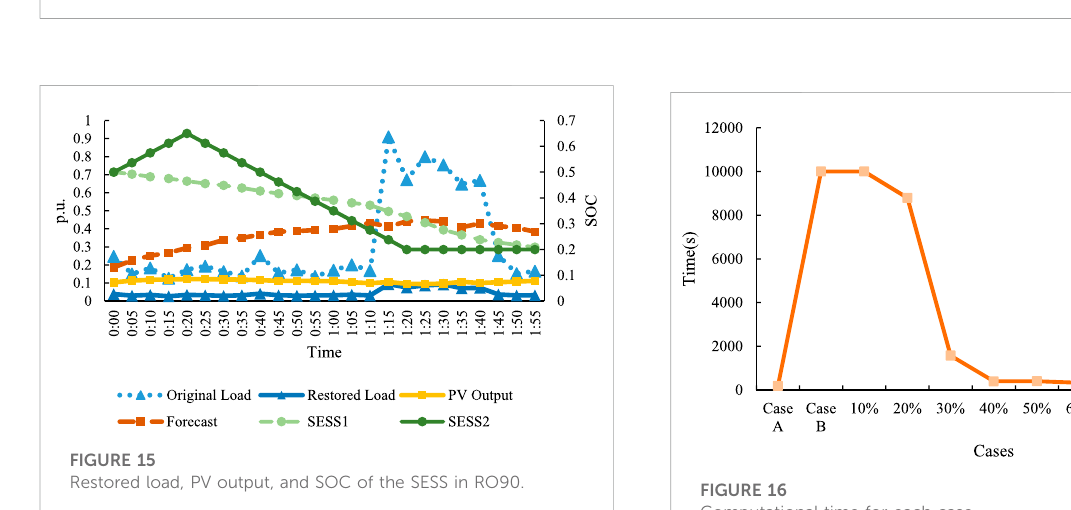
Computational time for each